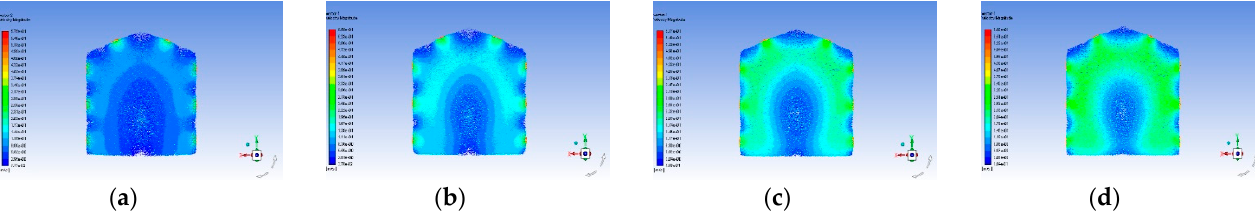
Figure 6. Velocity vector model of the guide box with different angles of the guide plate (main view). The angles of the deflector in the picture are ( a ) 150°, ( b ) 160°, ( c ) 170°, and ( d ) 180° from left to right.